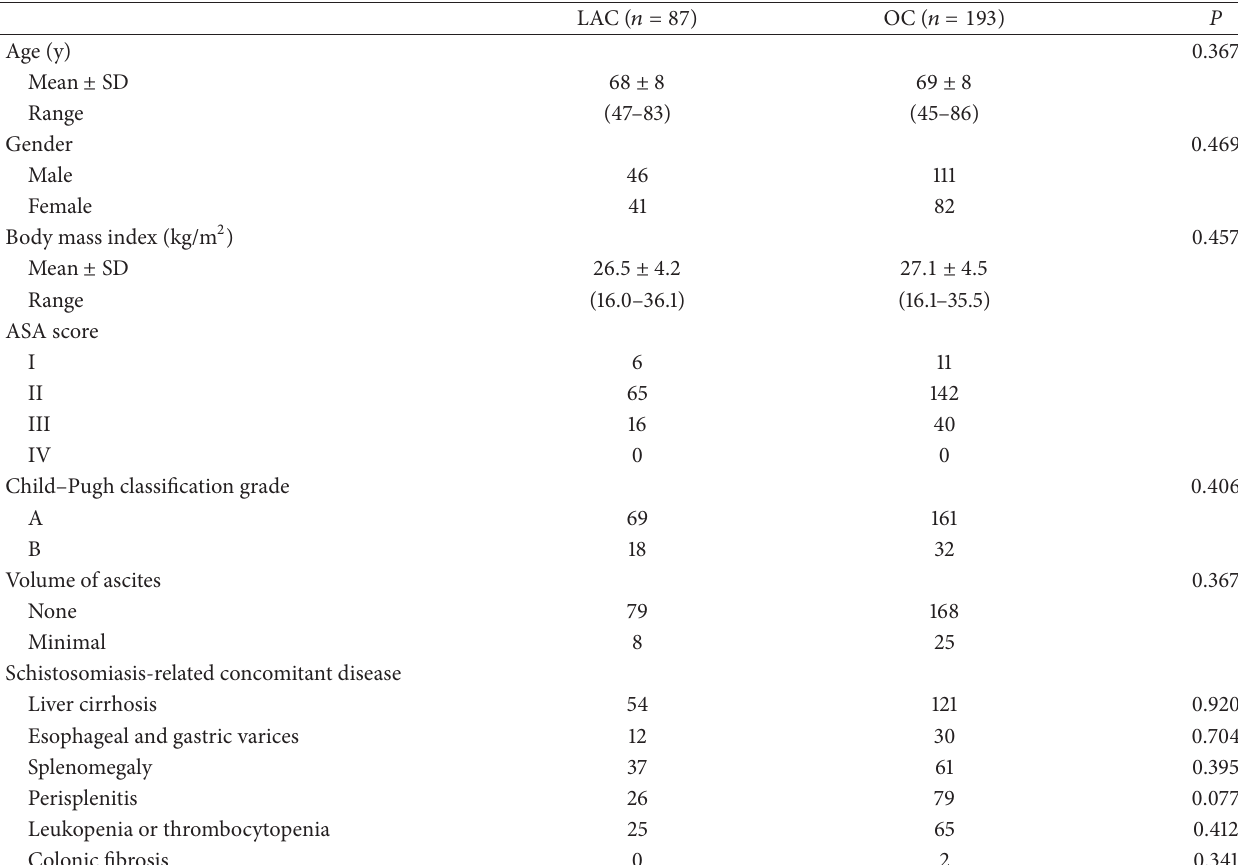
Table 1: Preoperative